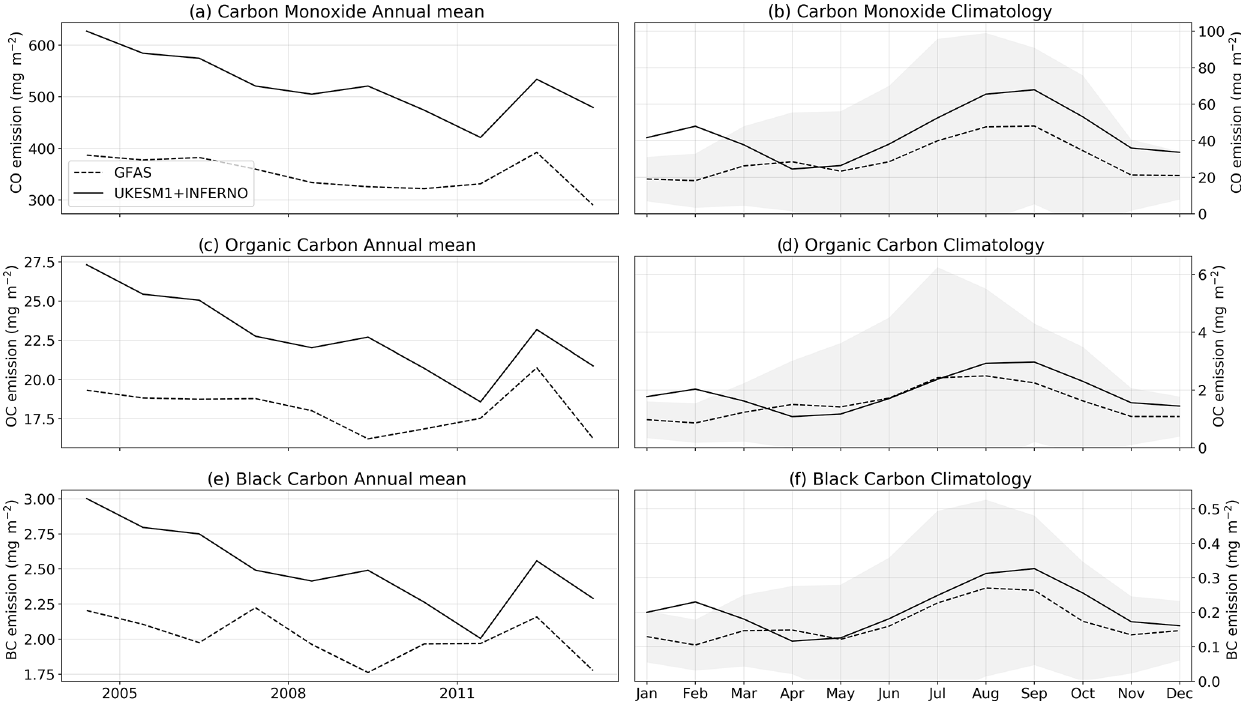
Figure 7. Annual mean time series and seasonal cycle climatology of biomass burning emissions (mgm − 2 ) of CO (a, b) , OC (c, d) and BC (e, f) for UKESM1+INFERNO (solid line) and GFAS (dashed line). The shaded area represents the standard error in the GFAS